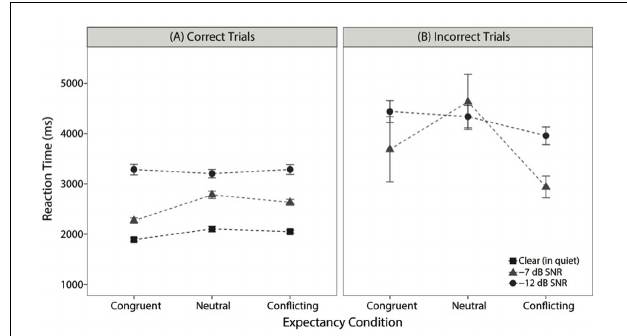
FIGURE 4 | Mean ( ± SE) for reaction time (RT), averaged across participants, for each expectancy and listening condition. (A) RT for correct trials only and (B) RT values for incorrect trials